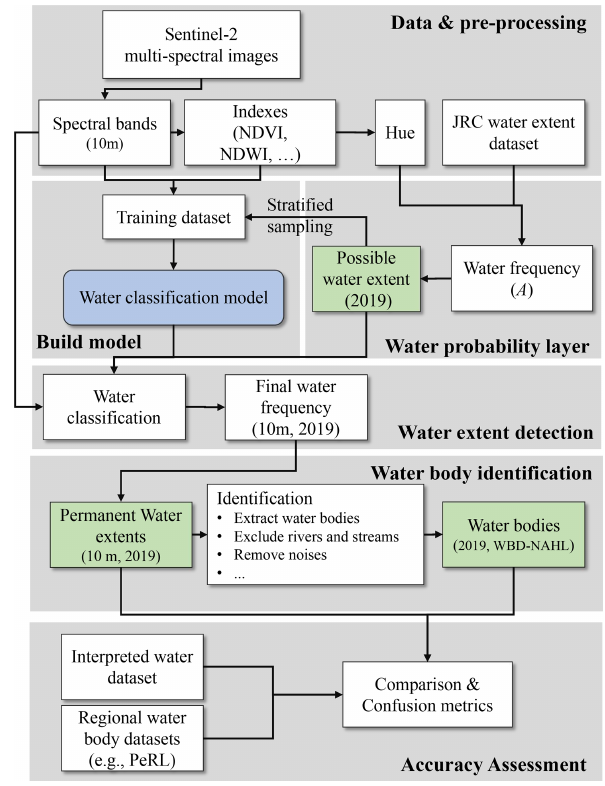
Figure 3. Flowchart for processing water extent and identifying wa- ter